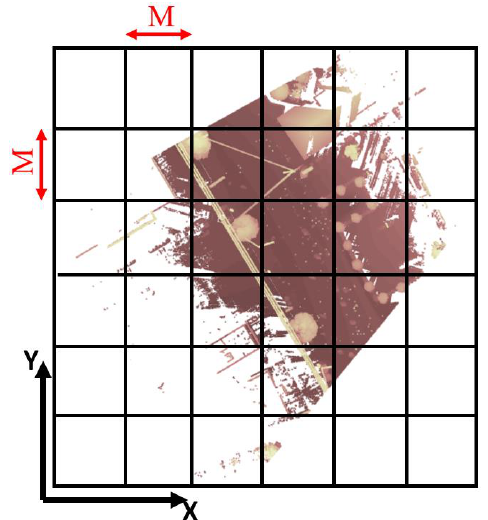
Figure 5. Method of eliminating low-height objects using